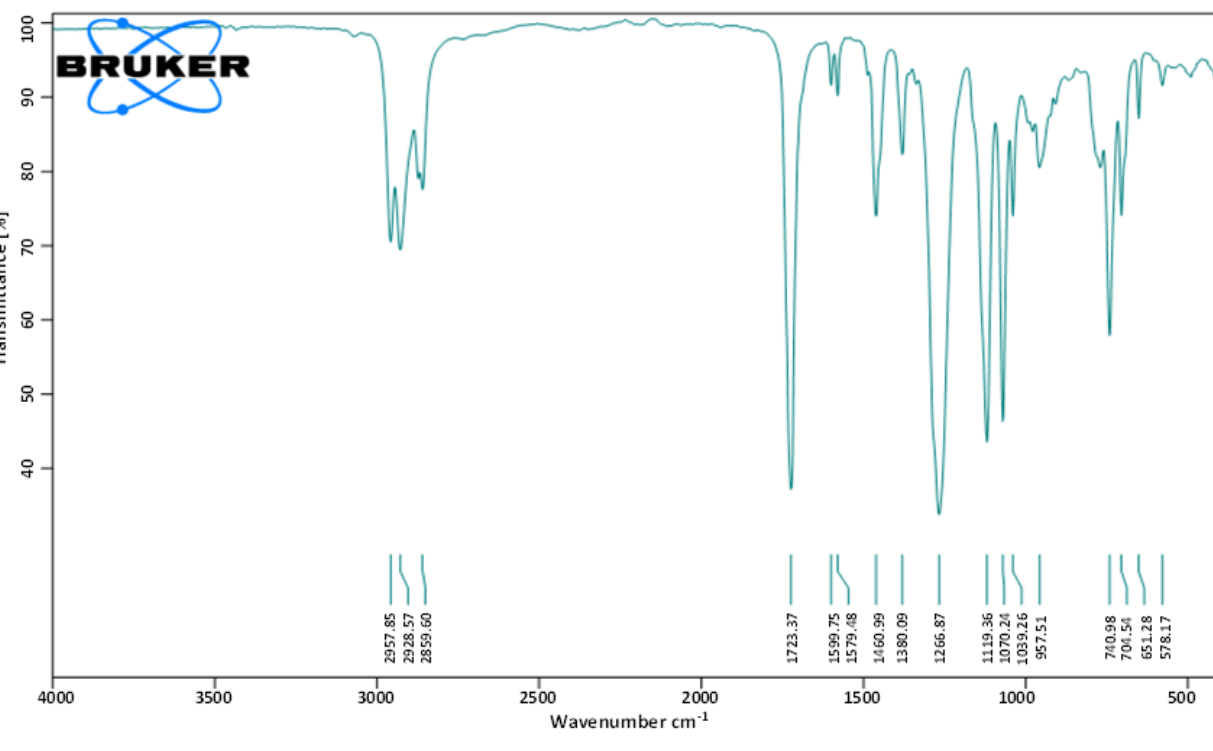
Figure 3. FT-IR spectrum of the bioactive fraction (F2) of ethyl acetate crude extract from L. plantarum BCH-1.